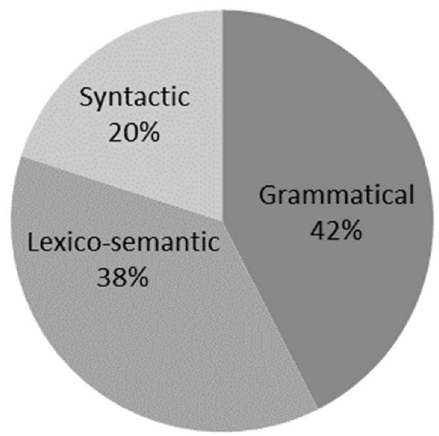
Figure 2. Errors in the French MT